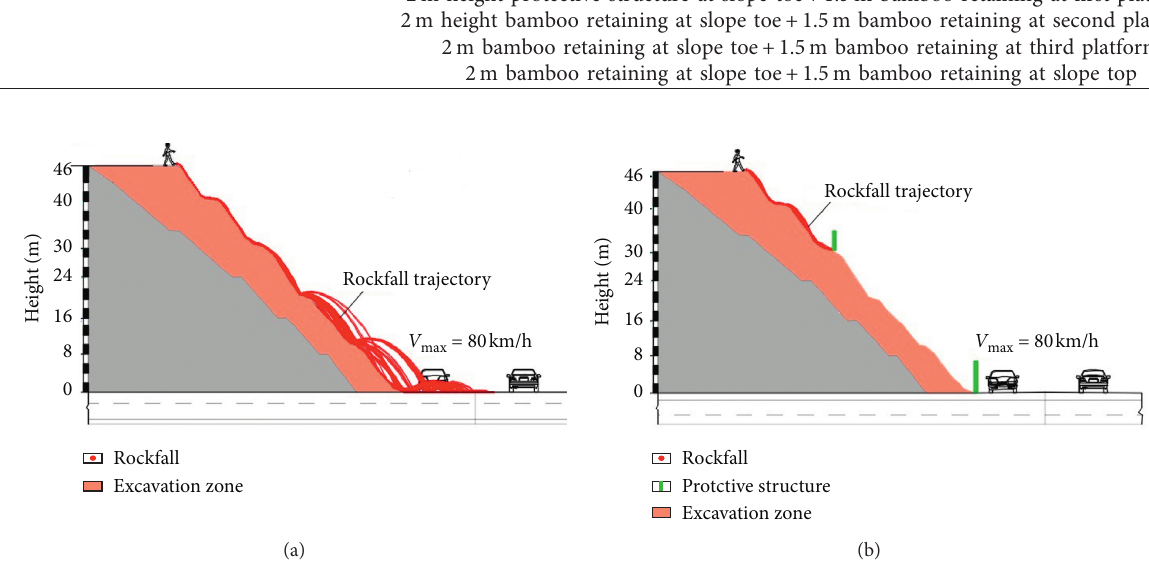
Figure 7: Trajectories of fall rock in different protection schemes (a) no protection structure (b) protection structure at three grade slope platform.